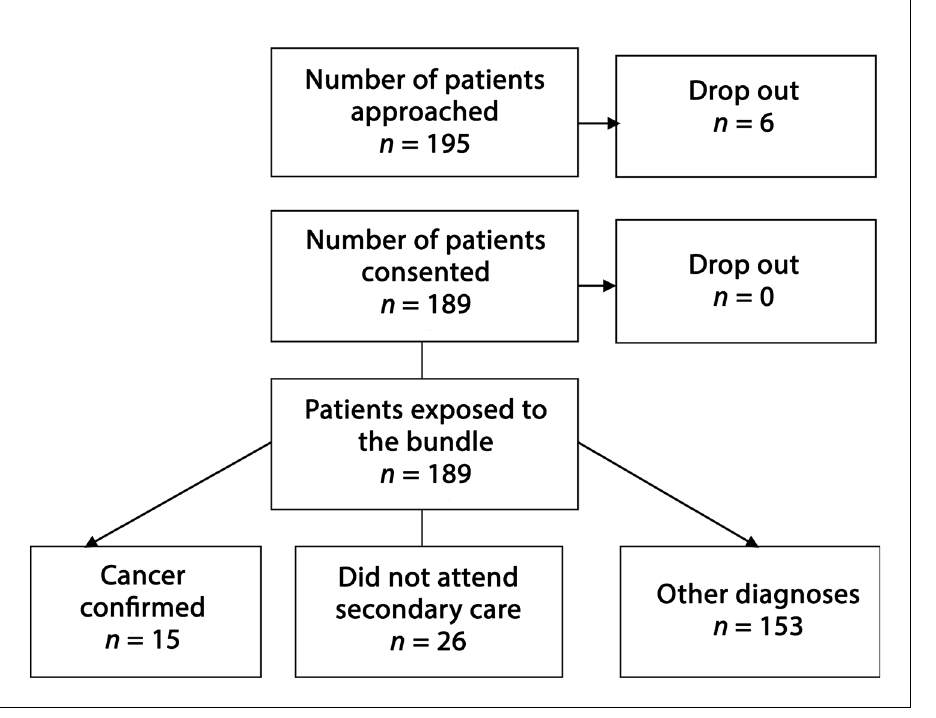
Figure 3. Flow diagram outlining details of patients who were recruited into